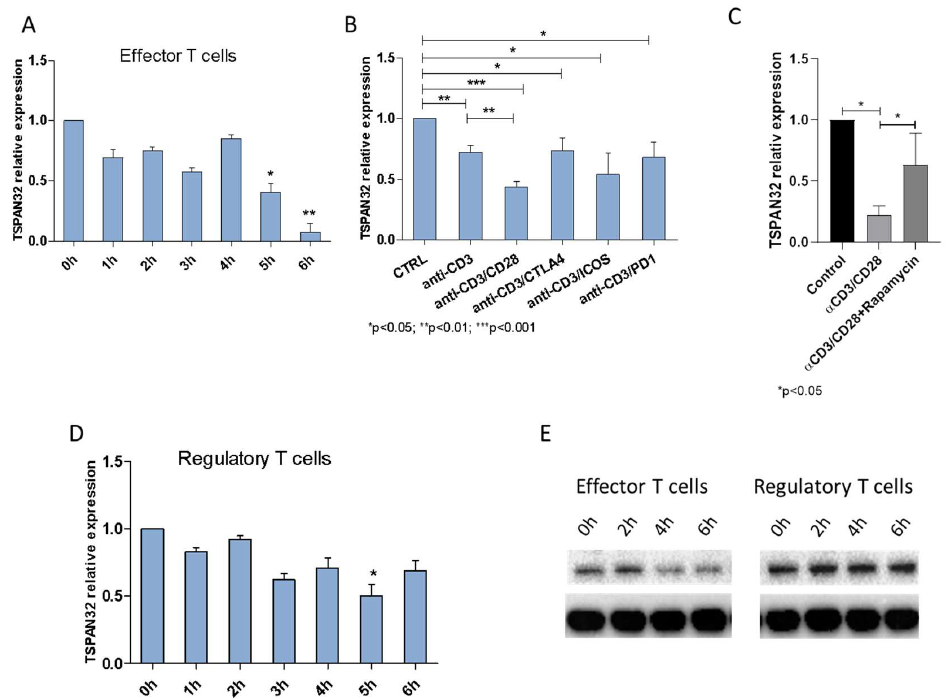
Figure 2. Expression of TSPAN32 during human T cell activation. ( A ) Expression of TSPAN32 was evaluated via real-time PCR, in CD4 + T e ff ector cells stimulated at di ff erent time points with anti-CD3 / CD28 antibodies or ( B ) with anti-CD3 alone or in combination with anti-CD28, anti-CTLA4, anti-PD1 and anti-ICOS antibodies for 36 h ( n = 3 independent replicates). ( C ) TSPAN32 levels in CD4 + e ff ector T cells upon anti-CD3 / CD28 stimulation, in the presence or absence of rapamycin 200 nM, were evaluated by real-time PCR ( n = 3 independent replicates). ( D ) TSPAN32 expression levels were evaluated at di ff erent time points upon activation of Treg cells via real-time PCR ( n = 3 independent replicates). ( E ) TSPAN32 protein levels were determined by western blot upon activation of e ff ector and regulatory T cells at di ff erent time points (pooled proteins of cells from 3 healthy donors). Data are shown as normalized mean ± SD and statistical analysis performed using one-way ANOVA followed by Bonferroni multiple test